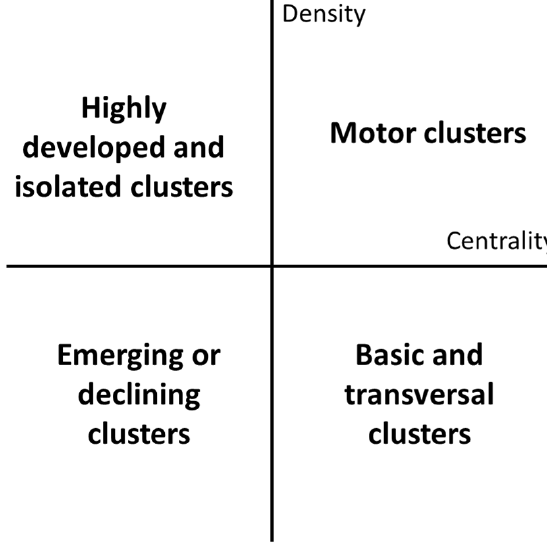
Figure 2. Strategic diagram. Source: Cobo